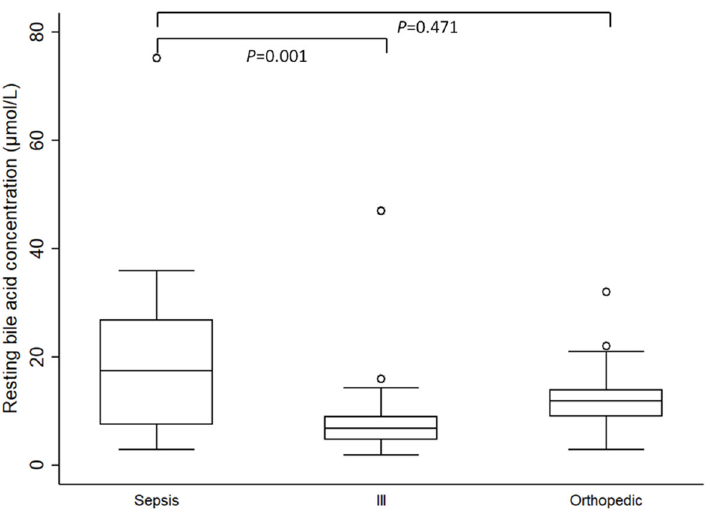
Figure 1. Comparison of resting serum bile acid concentrations in septic dogs (n = 26) with the ill (n = 21) and the orthopedic (n = 29) control groups. Boxes represent medians and interquartile ranges, and whiskers represent the range and individual points outliers. Septic dogs had significantly higher resting serum bile acid concentrations compared to ill dogs ( p = 0.001) however there were no differences between the septic and the orthopedic group ( p = 0.471).